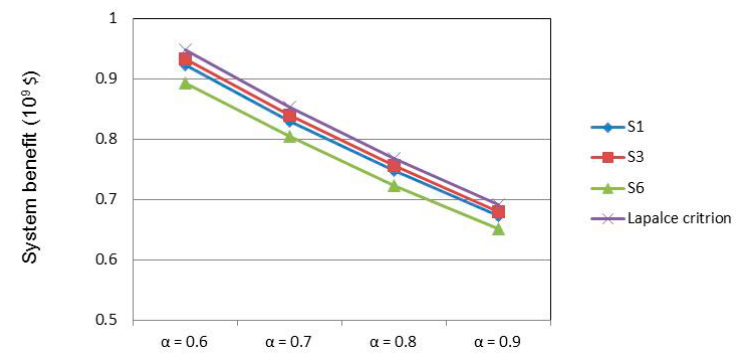
Figure 10. System benefit under S1, S3, S6 and Laplace criterion when α levels are varied.